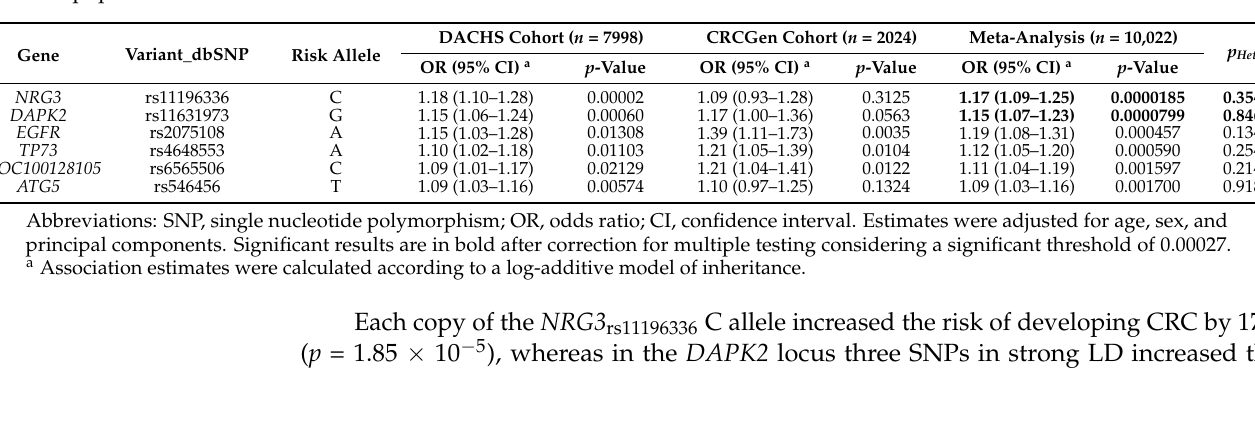
Table 1. Meta-analysis of the association between autophagy-related variants and CRC risk in the DACHS and CRC- Gen